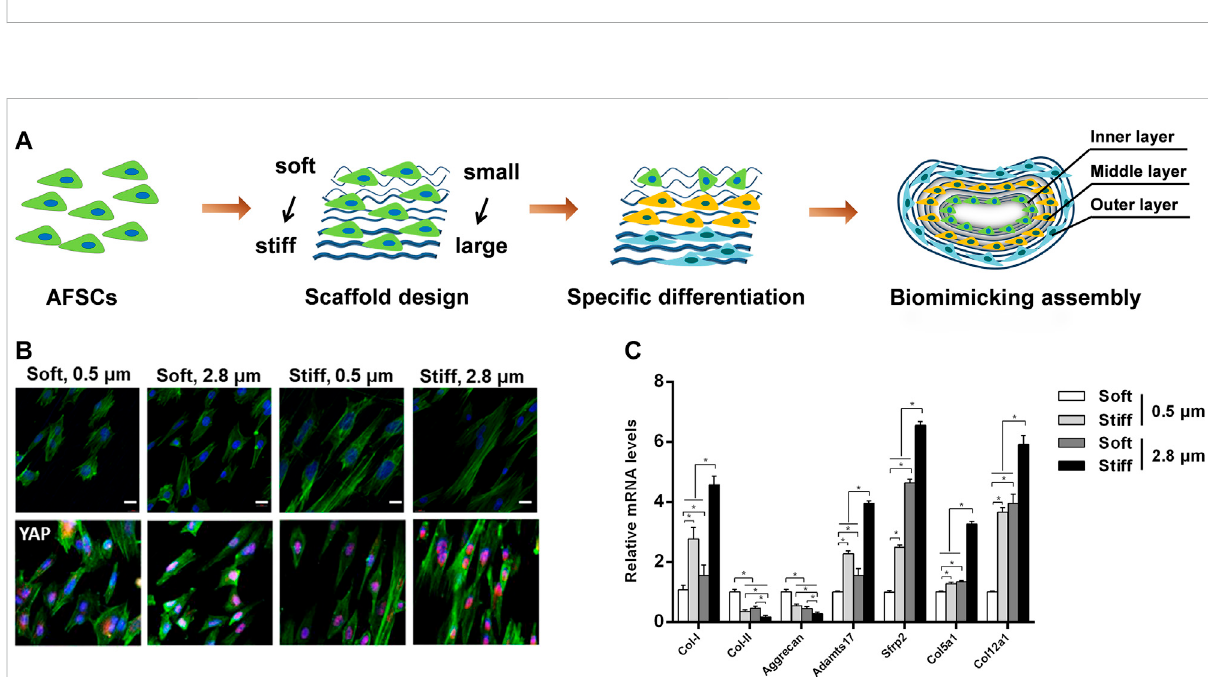
FIGURE 4 Combined effects of substrate topography and stiffness on the in fl uence of AFSC differentiation. (A) Assembly of electrospun fi brous membranes with different fi ber size and stiffness led to speci fi cally differentiated AFSCs that mimic the hierarchical strati fi ed structure of native AF tissue.ReproducedwithpermissionfromZhouetal.(Zhouetal.,2021). (B) ThemorphologyandYAPexpressionofAFSCsonscaffolds. (C) Expression of AF phenotypic marker genes cultured on electrospun fi brous membranes scaffolds for 7 days. Reproduced with permission from Chu et al. (Chu G. et al.,